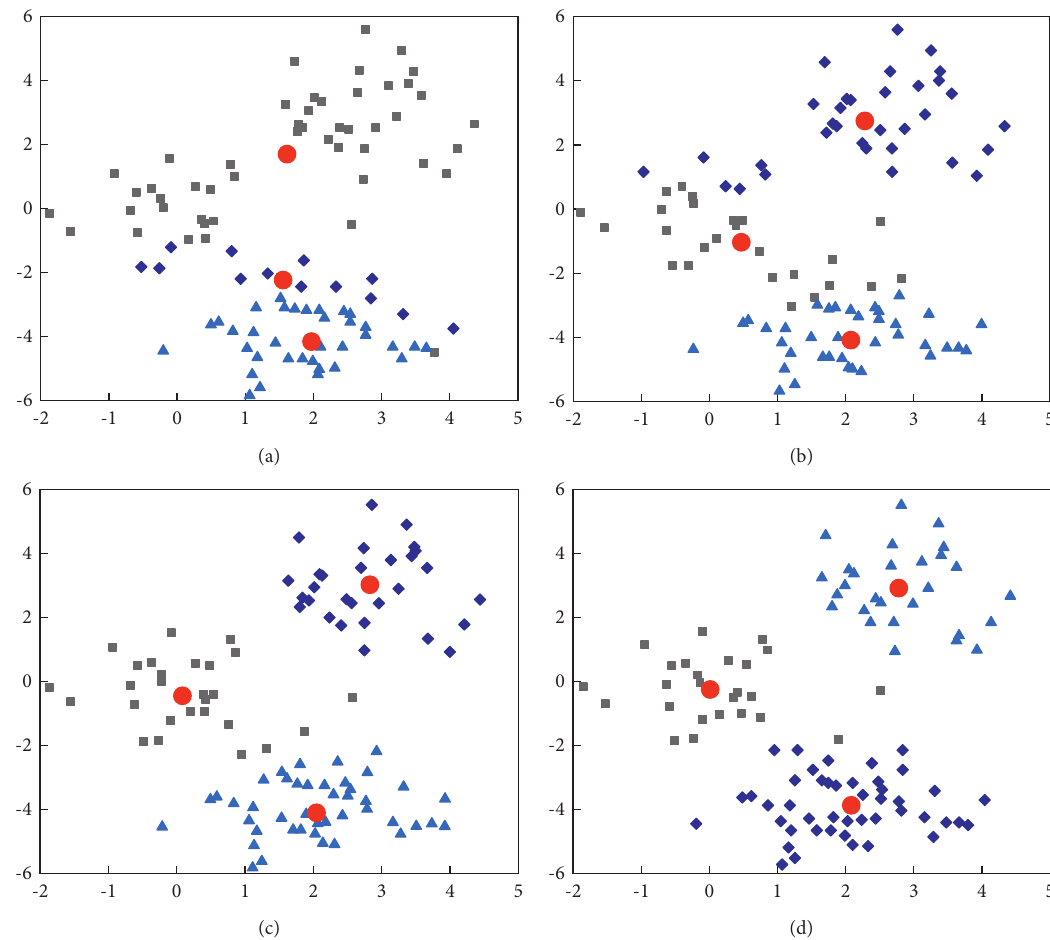
Figure 3: Demonstration process of mean algorithm. (a) First iteration. (b) Second iteration. (c) Third iteration. (d) Fourth